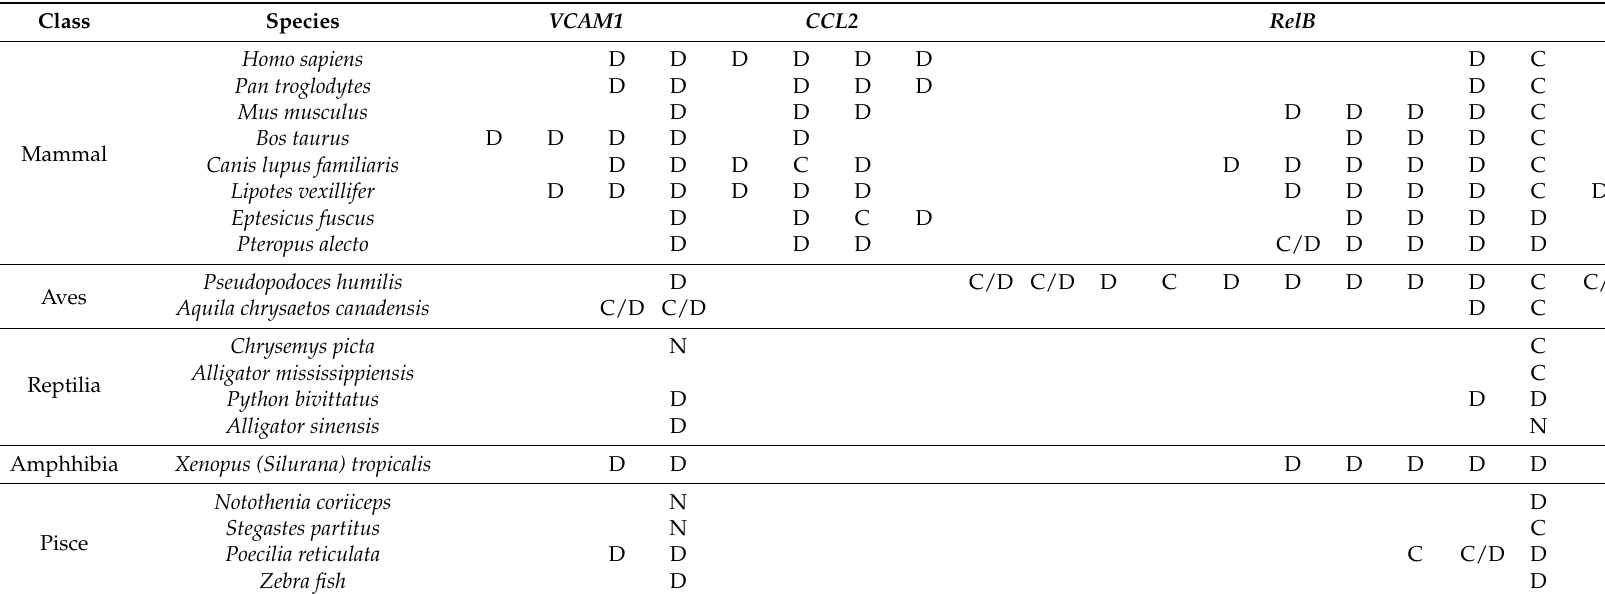
Table 1. Nucleotide at -1 position of κ B sites of VCAM1 , CCL2 and RelB genes (10 kb upstream to and 1 kb downstream transcription start sites) in various vertebrates. Class